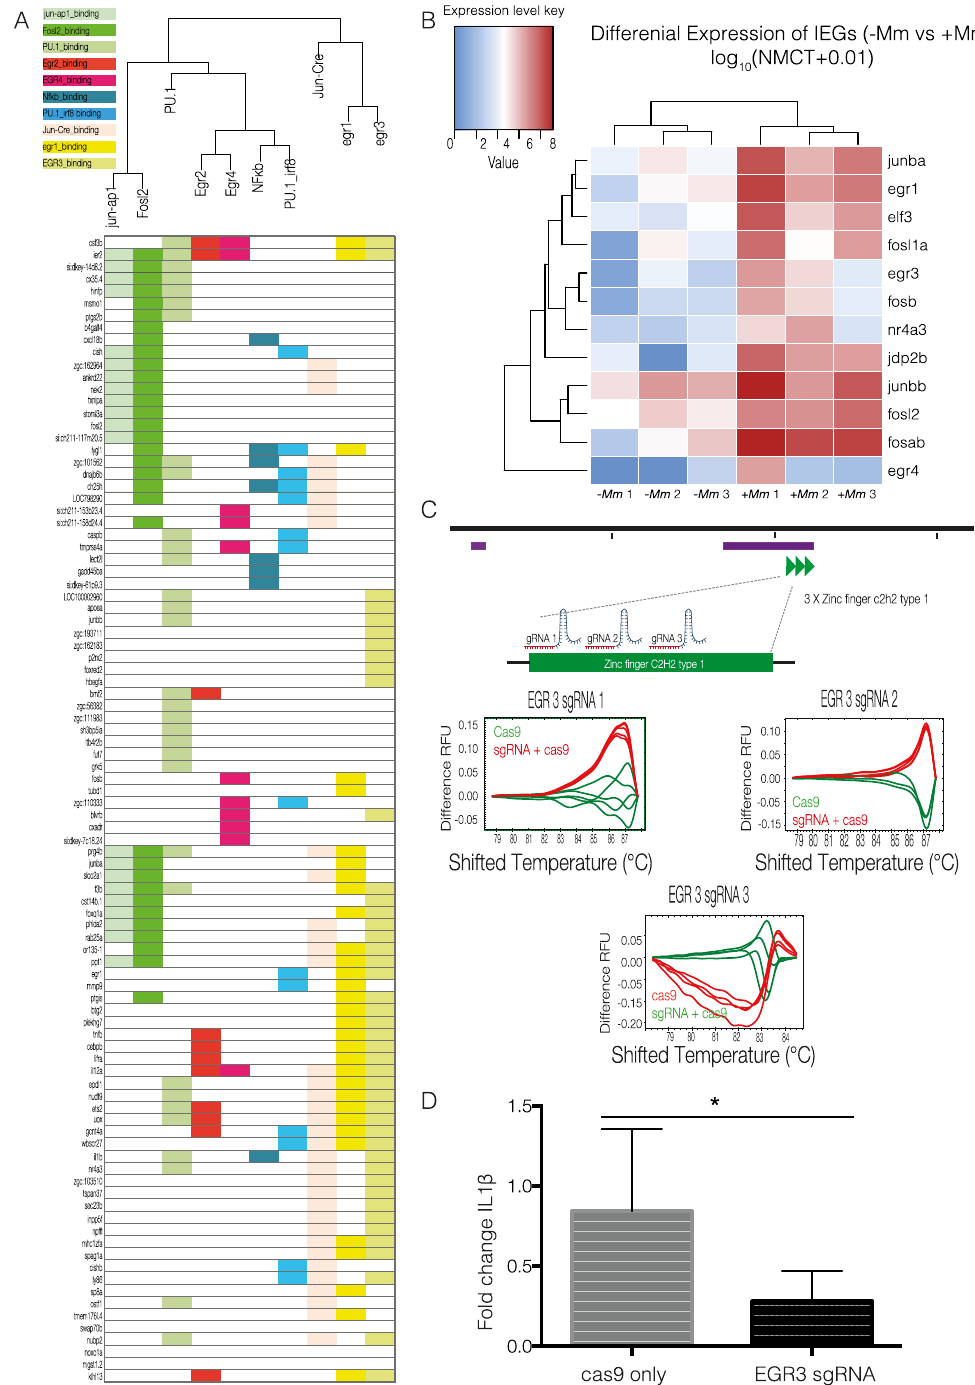
Figure 5. Analysis of transcription factors orchestrating neutrophil response to M . marinum . ( A ) Transcription factor motif search was performed on upregulated genes by de novo analysis using Homer. Dendrogram shows clustering of statistically significant transcription factors and upregulated genes with corresponding transcription factor binding sites highlighted below. ( B ) Heatmap shows the log 10 (normalised counts (NMCT) + 0.01) of selected differentially expressed transcripts for initial early response genes (IEGs) (adjusted p-value < 0 . 05 ). Red - high expression. White - medium expression Blue - low expression. ( C ) egr3 sgRNA tests for efficiency in inducing DNA double-strand breaks. sgRNAs were injected into the 1-cell stage and genomic DNA extracted at 24 hpf. High resolution melting curves from 3–4 individual embryos injected either with Cas9 mRNA only (green) or co-injected with Cas9 mRNA and egr3 sgRNA (red) are shown. ( D ) Bar graph representing il1 β mRNA levels measured at 3 dpi by qPCR. Wildtype fish were co-injected with Cas9 mRNA and 3 sgRNAs for targeted knockout of egr3 or Cas9 mRNA only at the one cell stage, followed by injection of M . marinum at the 32–512 cell stage. Statistical significance was determined by two-tailed unpaired students t-test with Welch’s correction ( * p < 0 . 05